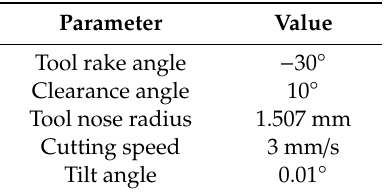
Table 2. Parameters in plunge cutting experiment.